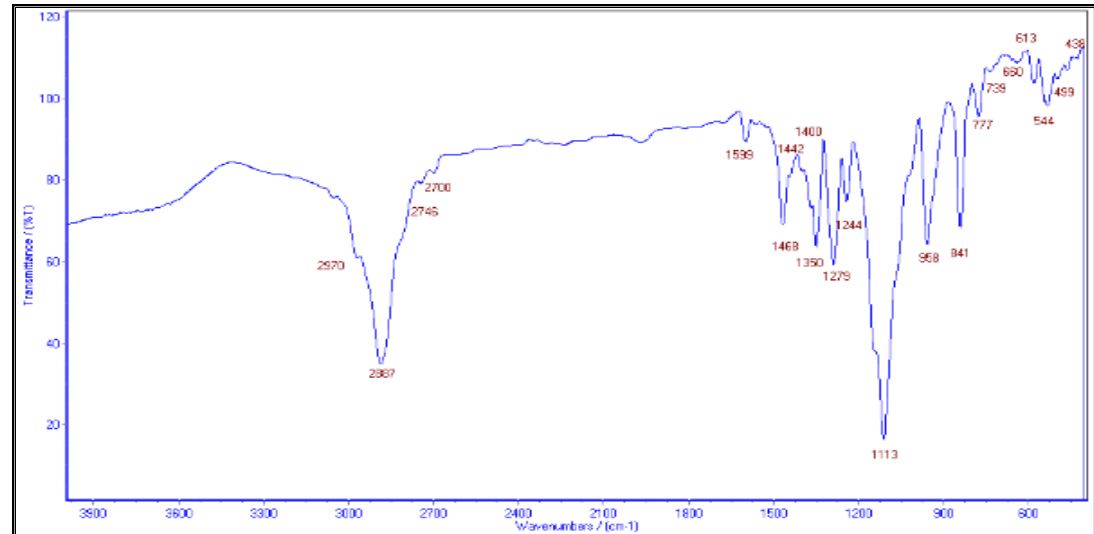
Figure 10.FTIR spectrum of the best formula (SD15) Differential scanning calorimetry (DSC) The DSC thermograms of EXB and PXM 407 were represented in figures 11 and 12 show a sharp endothermic peak at 138.00°C and 58.2°C, respectively. They represented the melting point of EXB and PXM 407, which, revealed the crystalline nature of the drug and the polymer as previously reported (31,32) .